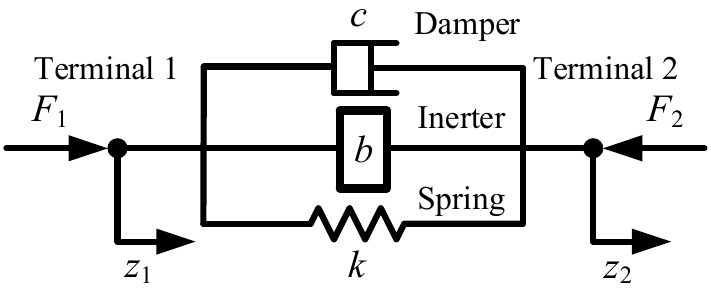
Figure 1. Diagram of a typical ISD system.